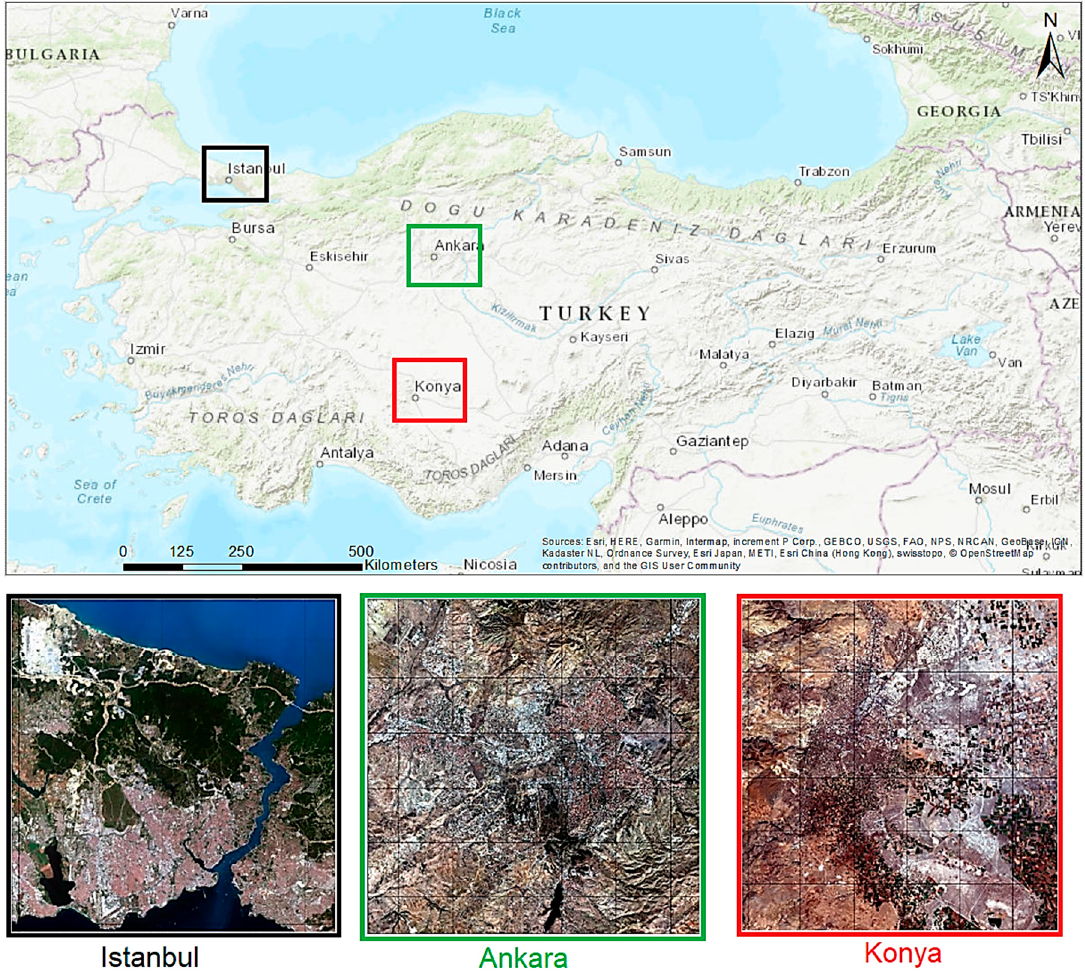
Figure 1. Location map of the main study area and the test regions (Country map from ESRI©, California, USA, closer look from the natural colour composite of the Sentinel-2A).